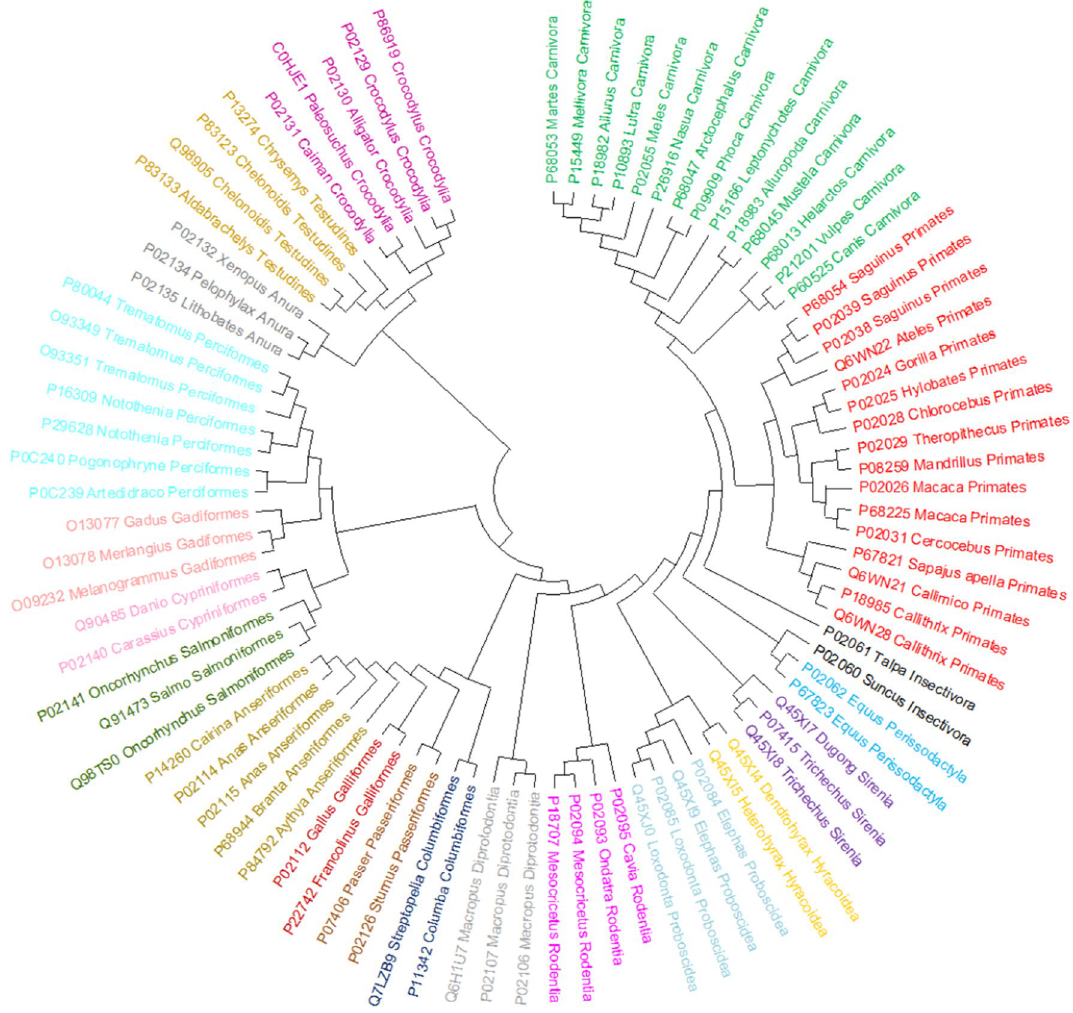
Figure 15. The phylogenetic tree of 88 betaglobin proteins constructed by our method